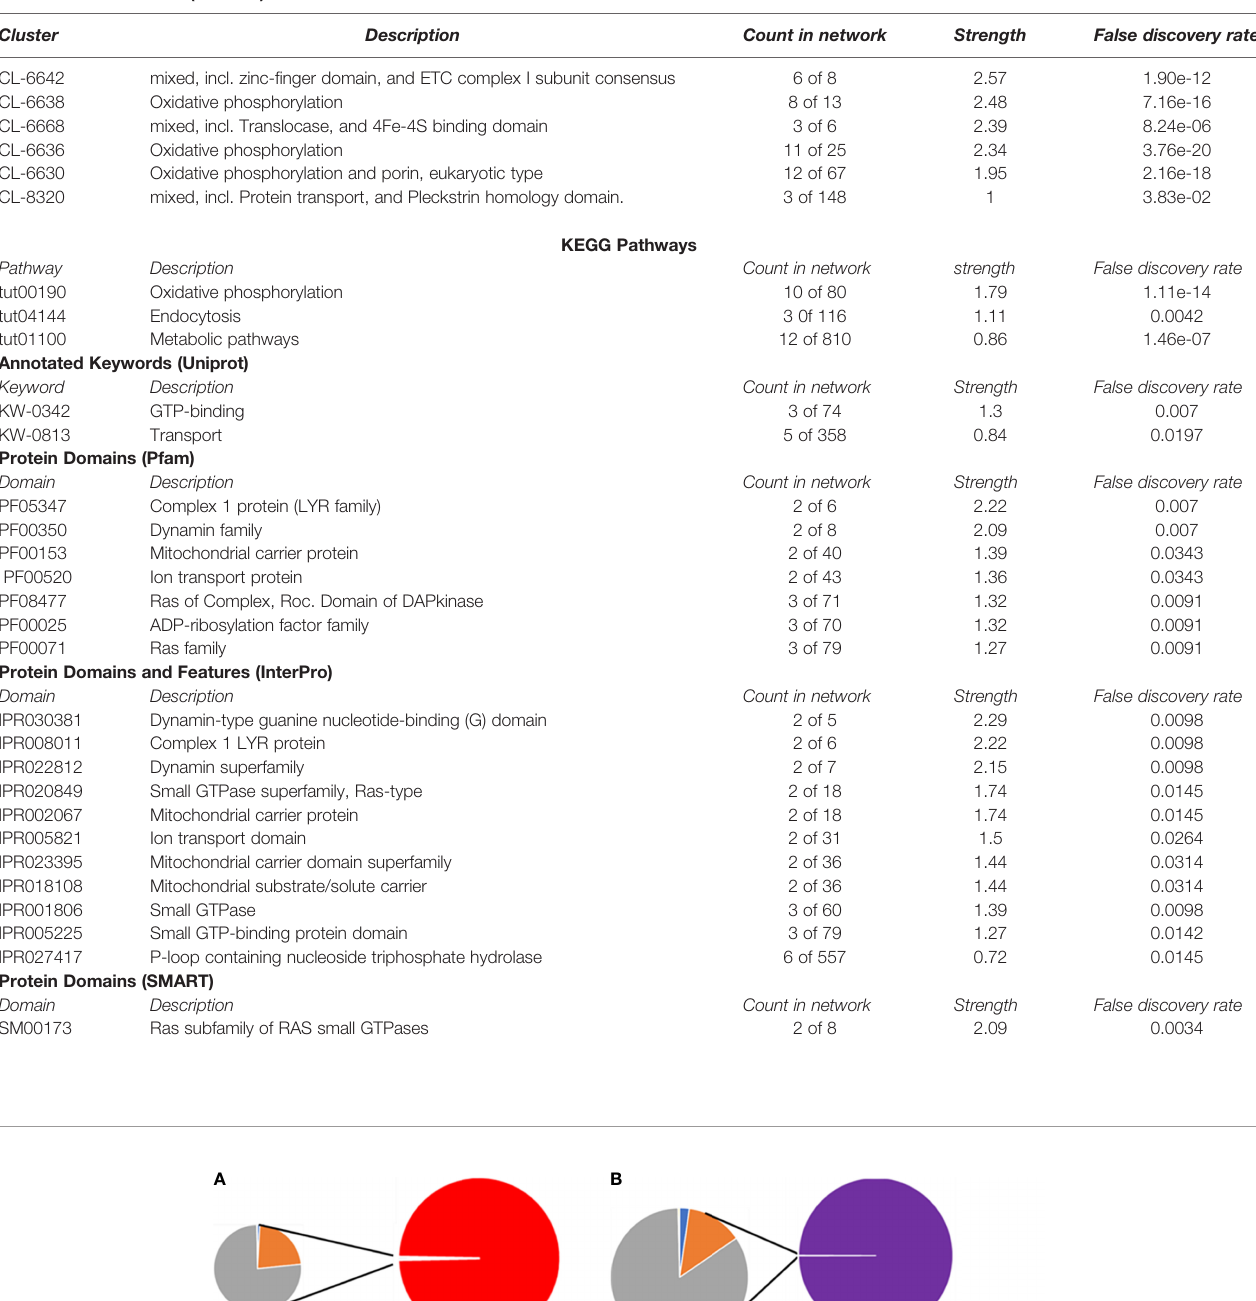
TABLE 3 | Functional enrichment in predicted protein network (STRING).